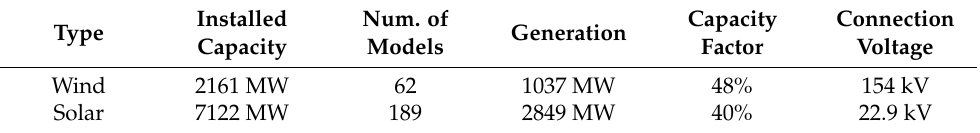
Table 13. Renewable energy model for a dynamic